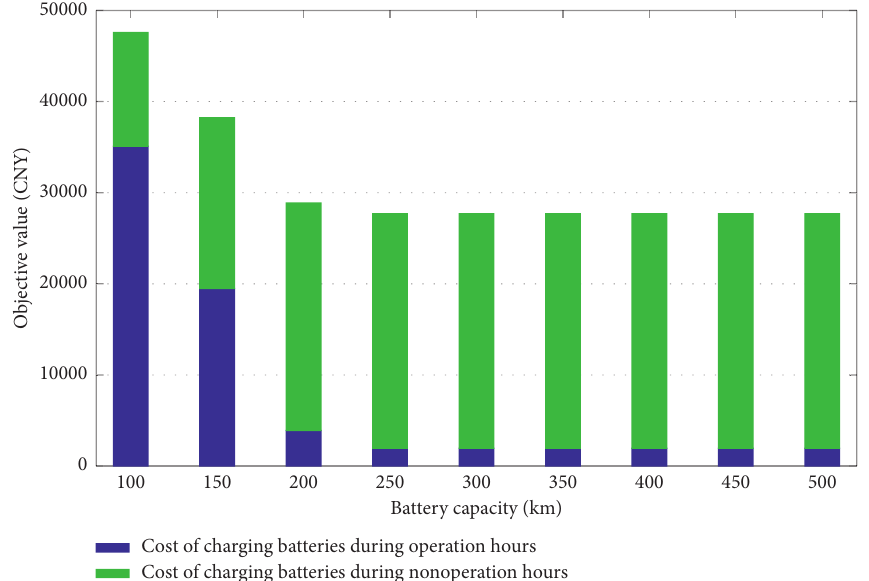
Figure 10: Effect of different battery capacities on charging